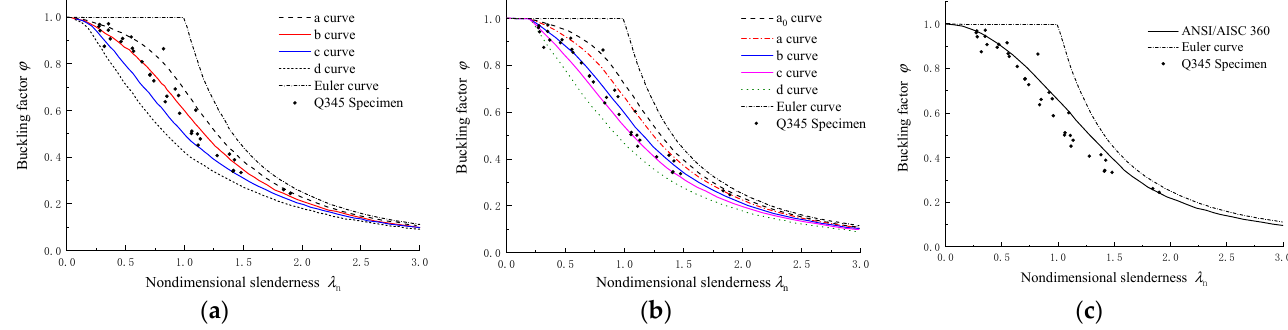
Figure 11. Comparison of FE results with design curves for Q345 specimens: ( a ) GB50017; ( b ) EN1993-1-1; ( c ) ANSI/AISC360.